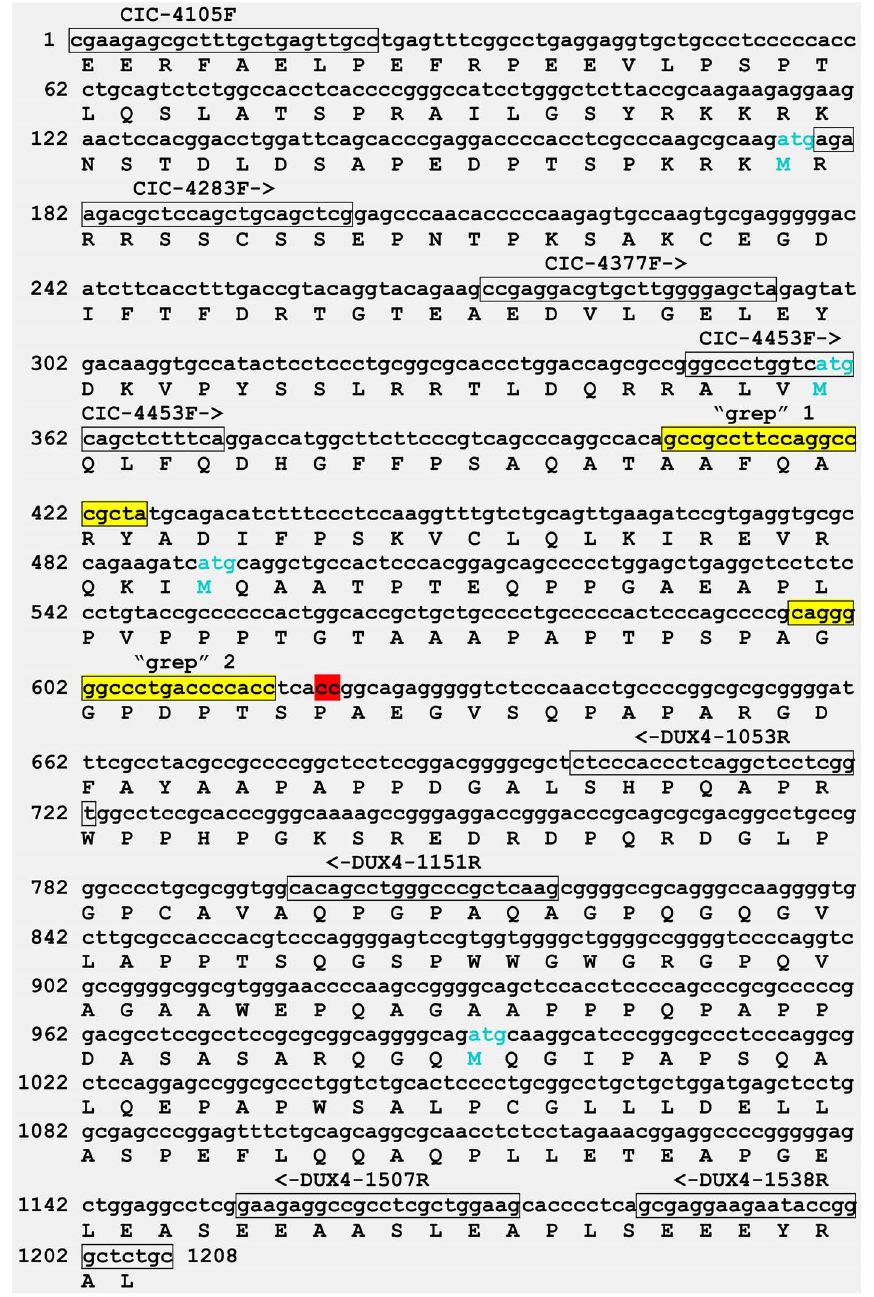
Figure 4. A putative 1208 bp CIC-DUX4 fusion transcript which would have been amplified using the the forward CIC-4105F and reverse DUX4-1538R primers. All the primers used in the study are denoting the primers sequences (in box) together with orientation (arrows). The search sequences ‘‘GCCGCCTTCCAGGCCCGCTA’’ (‘‘grep’’ 1) and ‘‘CAGGGGGCCCTGACCCCACC’’ (‘‘grep’’ 2) used as search terms in the ‘‘grep’’ command-line utility are colored yellow and in box. The fusion point between CIC and DUX4 is in red. The part of the protein coded by this CIC-DUX4 fusion transcript fragment is shown under the nucleotide sequence. The nucleotide sequence has been deposited in the GenBank with accession number